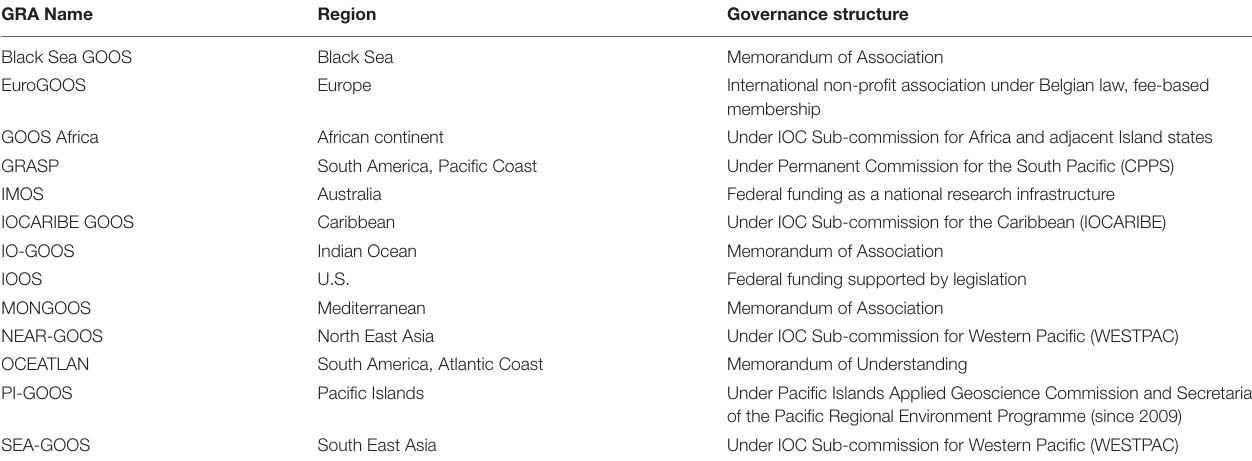
TABLE 1 | Summary of GRA governance structures (GOOS,